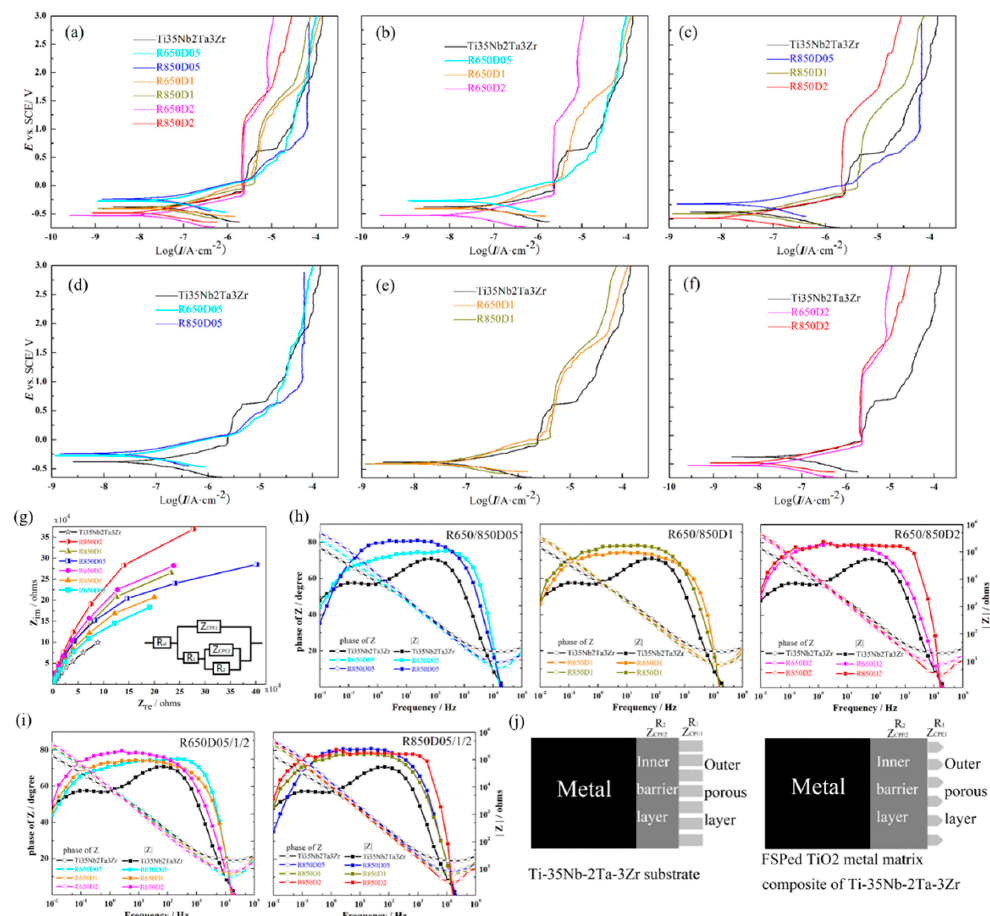
Figure 5. The corrosion behavior of the substrate and TiO 2 micro/nano-composite layers in Hank’s solution: ( a – h ) poten- tiodynamic polarization curves, ( g – j ) EIS pattern: ( g ) Nyquist diagram with equivalent circuit, ( h ) Bode diagrams of TiO 2 micro/nano-composite layers at the different rotation speeds, ( i ) Bode diagrams of TiO 2 micro/nano-composite layers at the different amount of TiO 2 added, ( j ) schematic diagrams of the substrate and TiO 2 micro/nano-composite layers. Re- produced with permission from [96], copyright Elsevier, 2019.